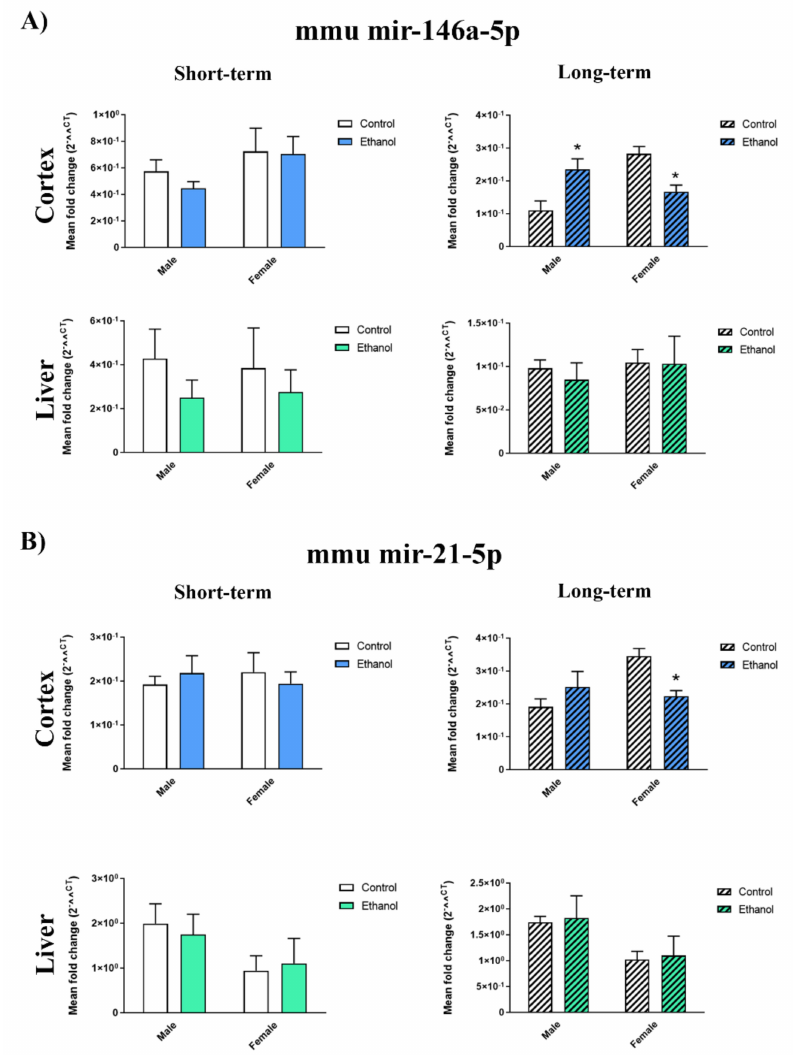
Figure 4. E ff ects of ethanol in the inflammatory-related miRNA profile in the cerebral cortices and livers of adolescent WT mice. Graphs represent the expression of ( A ) mir-146a-5p and ( B ) mir-21-5p after a 24-h and 2-week withdrawal period of ethanol or saline treatment in the female and male adolescent WT mice (PND 44 and PND 58). Data represent mean ± SEM, n = 6 independent experiments. * p < 0.05 compared to their respective control counterparts, according to the two-way ANOVA followed by the Bonferroni post hoc